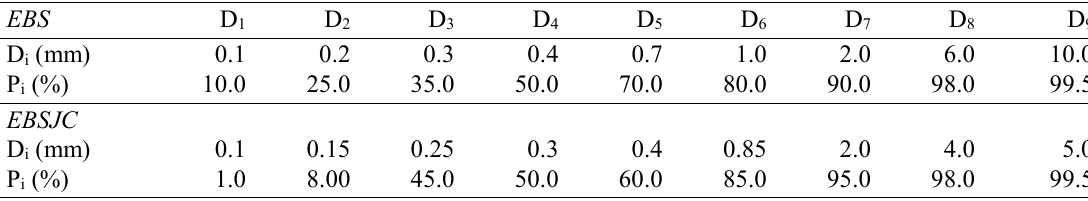
Table 1c Sieve analysis of eroded sediment in the EBS and